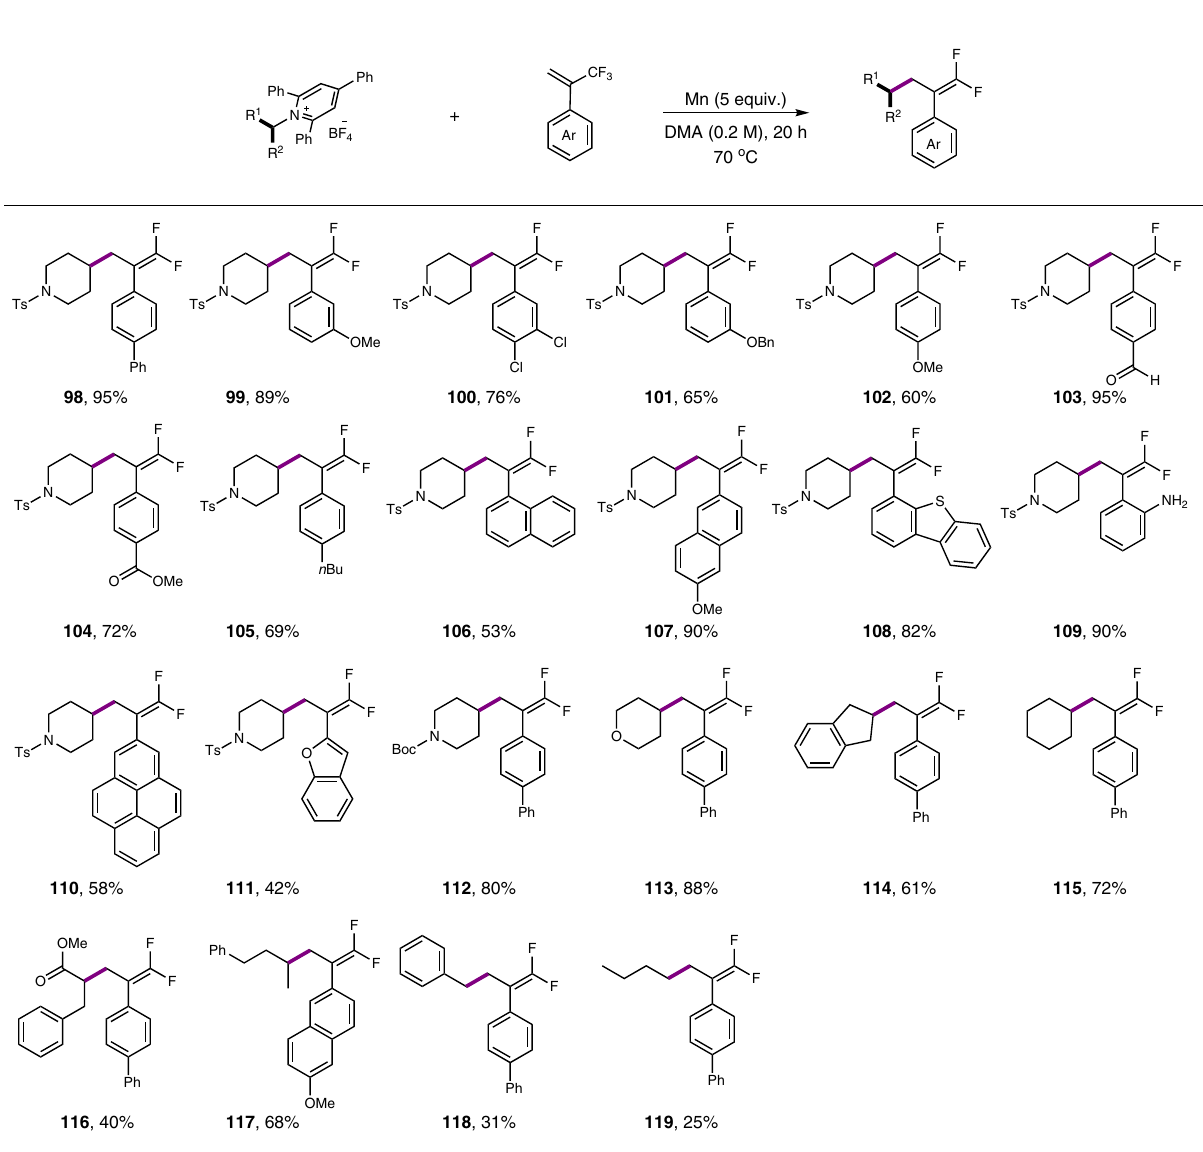
Fig. 8 Scope of deaminative di fl uoroallylation. Reaction conditions: N -alkylpyridinium salts (0.26 mmol), 1-(tri fl uoromethyl)alkene (0.2 mmol), Mn (1.0 mmol), in DMA (0.2 M), 70 °C, N 2 , 20 h; yields are for isolated